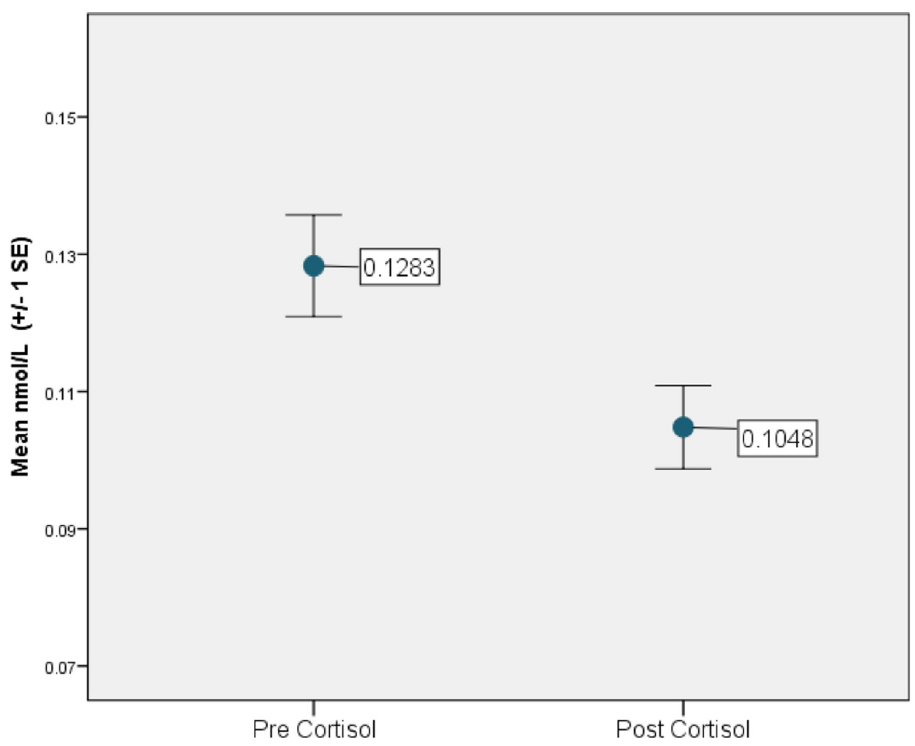
Fig 5. Study participant average salivary cortisol concentrations before and after the River’s Edge experience at the Saint Louis